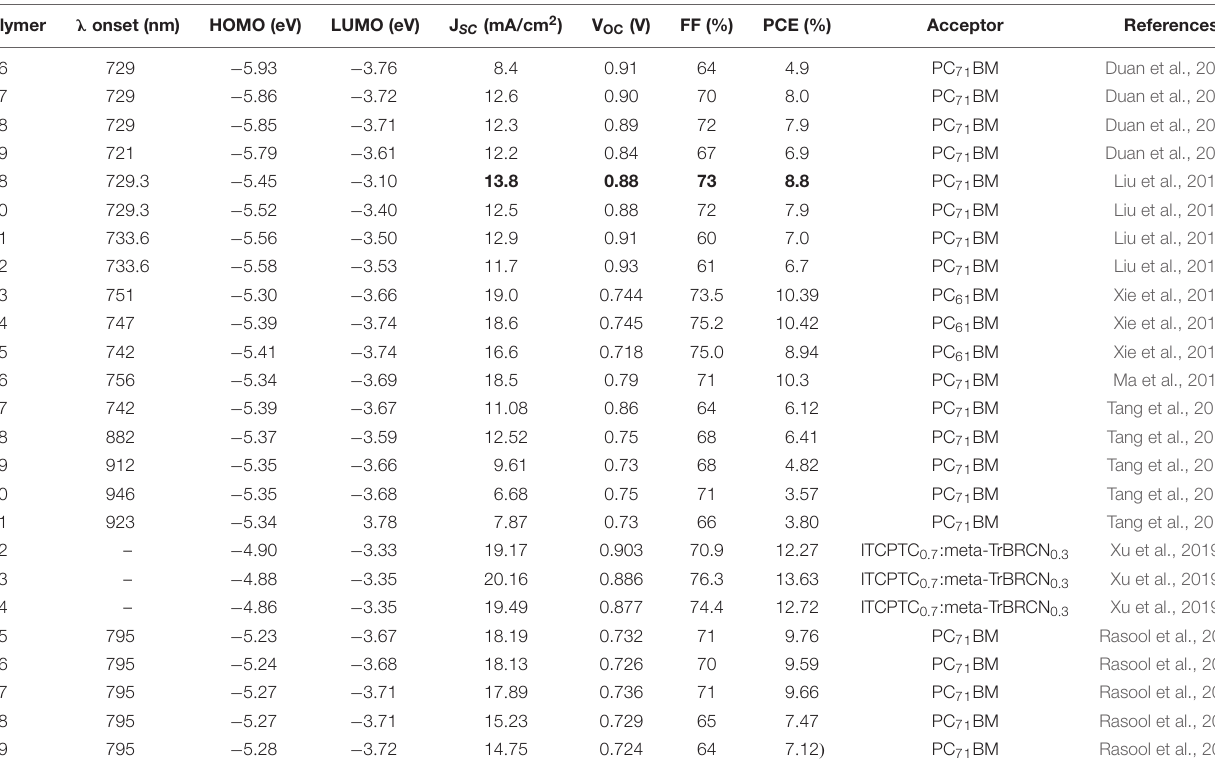
TABLE 6 | Summary of optical, electrochemical, and photovoltaic properties of polymers ( P56 – P79 ). Polymer λ onset